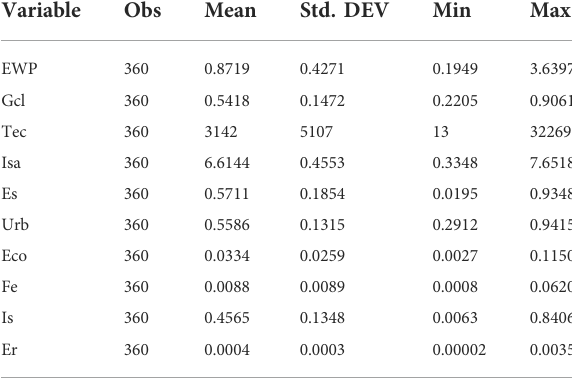
TABLE 3 The descriptive statistics of the